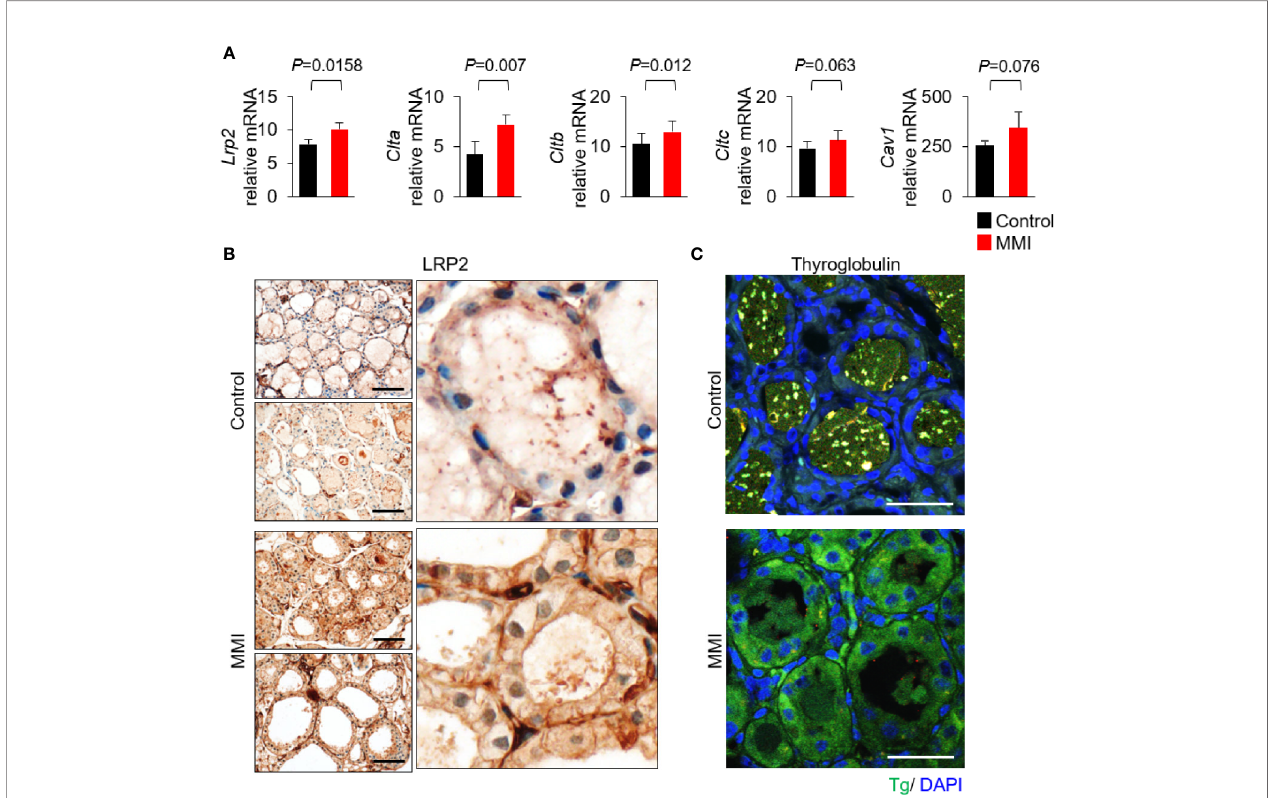
FIGURE 2 | Elevated expression of Lrp2/megalin in MMI-treated mouse thyroid. (A) mRNA levels of Lrp2/megalin were higher in the thyroid of MMI-treated mice than in the control group ( P = 0.0158). Two genes associated with Tg endocytosis, Clta and Cltb , were signi fi cantly upregulated in the thyroid of MMI-treated mice relative to the control group ( Clta , P = 0.007; Cltb , P = 0.012). mRNA levels of Cav1 ( P = 0.076) and Cltc ( P = 0.063) were elevated, but the difference was not signi fi cant. (B) Immunohistochemical staining of LRP2/megalin at the apical plasma membrane of thyroid follicular cells in untreated control mice. In MMI-treated mice, LRP2/megalin was mainly cytoplasmic, but was also detected at the plasma membrane of thyroid follicular cells. Scale bar, 25 m m. (C) Immuno fl uorescence showing localization of Tg. Compared with the control, the level of Tg was markedly higher in the follicular cell cytoplasm of MMI-treated mice. Tg was absent from thyroid follicle lumen of MMI-treated mice but was detectable within the thyroid follicle lumen of the control group. Scale bar, 25 m